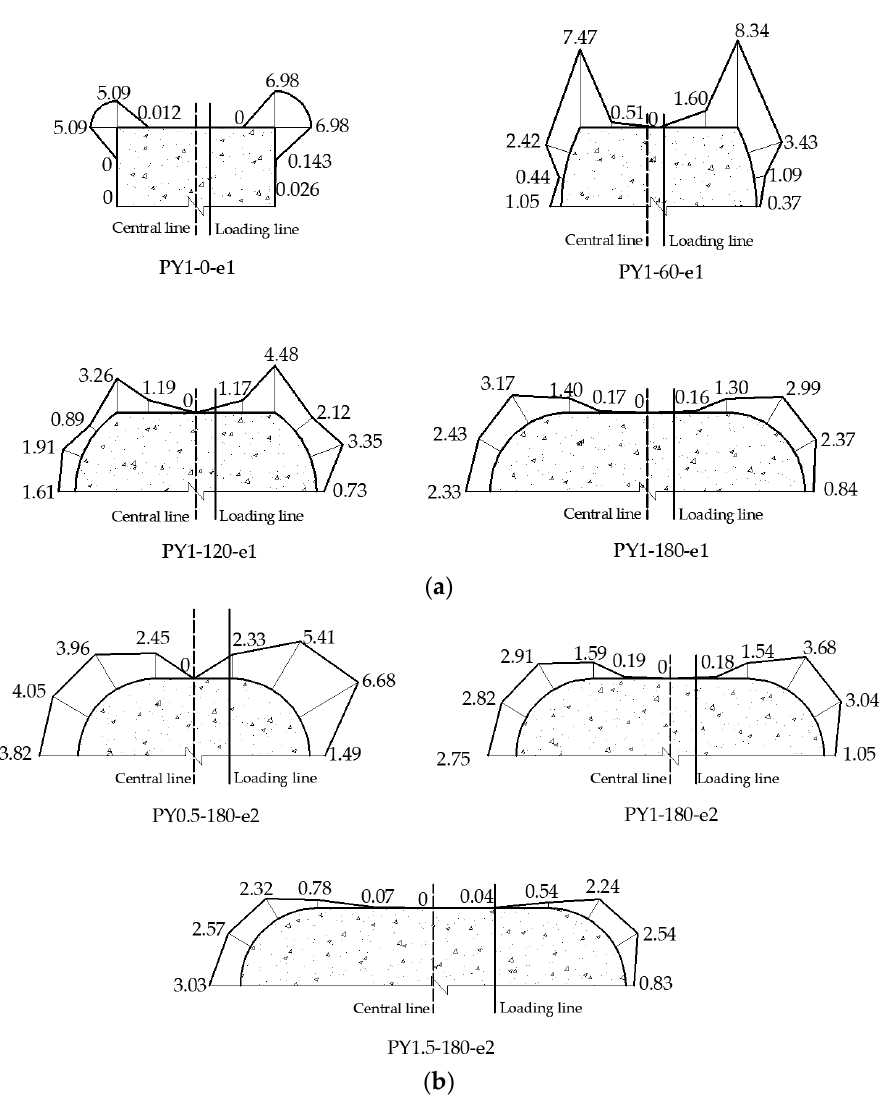
Figure 11. Contact stress between steel tube and concrete at mid-length for RRCFST columns with different parameters: ( a ) central angle; ( b ) aspect ratio.